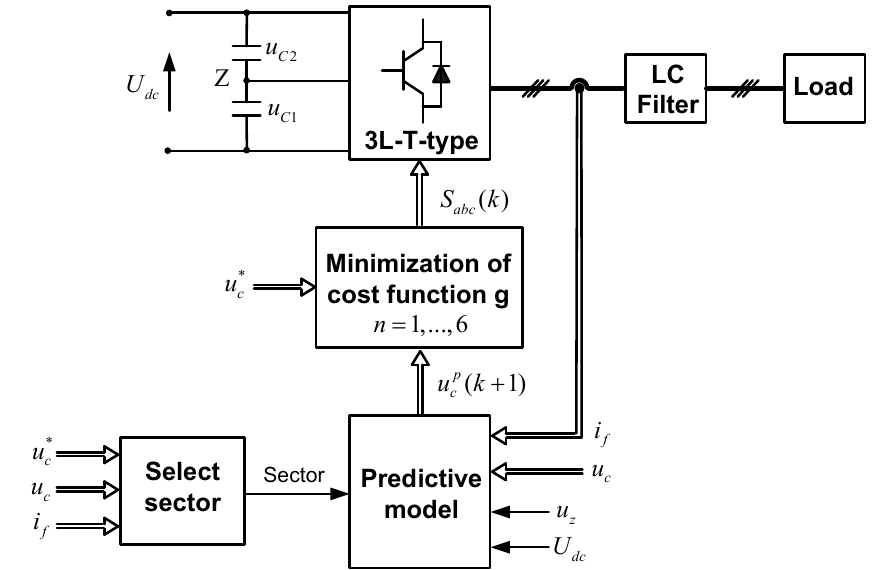
Figure 3. Block diagram of the proposed control